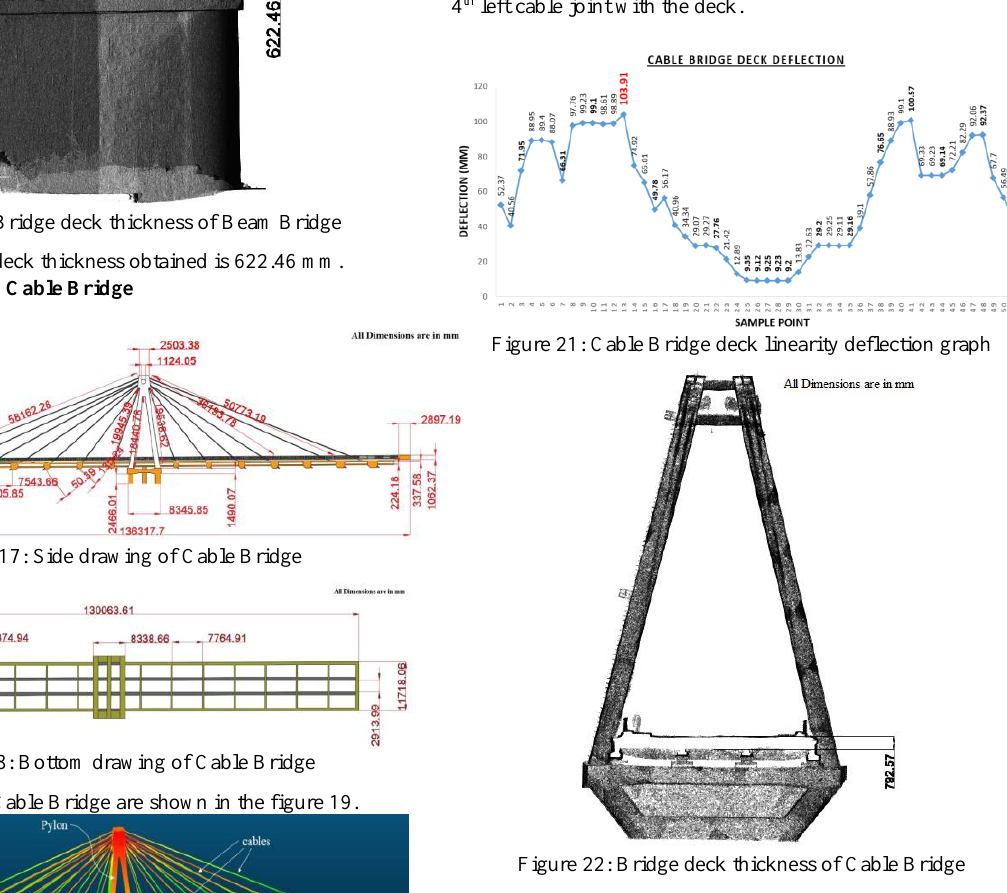
Figure 19: Parts of Cable Bridge